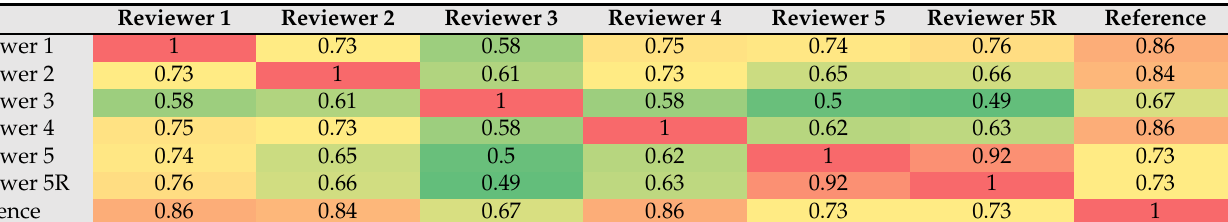
Table 5. Pearson’s correlation matrix between reviewers. Reference: consensus of 5 reviewers. Reviewer 5R: second repetition of reviewer